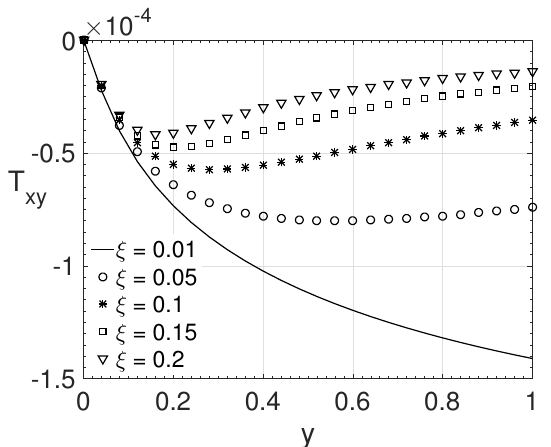
Figure 12. ξ influence on the wall-normal variation y of the extra-stress tensor component T xy . Dimensionless parameters: Re = 1000, β = 0.5, (cid:101) = 0.25 and Wi =